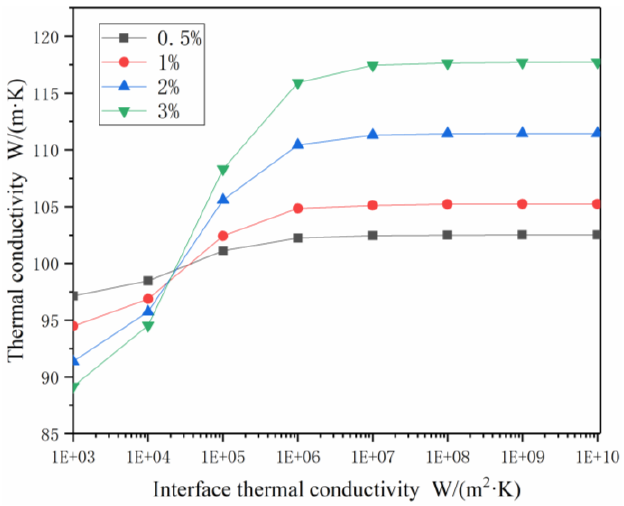
Figure 9. The k c values of GNPs/Co models with randomly distributed GNPs as a function of the C G-Co at GNP loadings of 0.5% vol., 1% vol., 2% vol., 3% vol. 2.